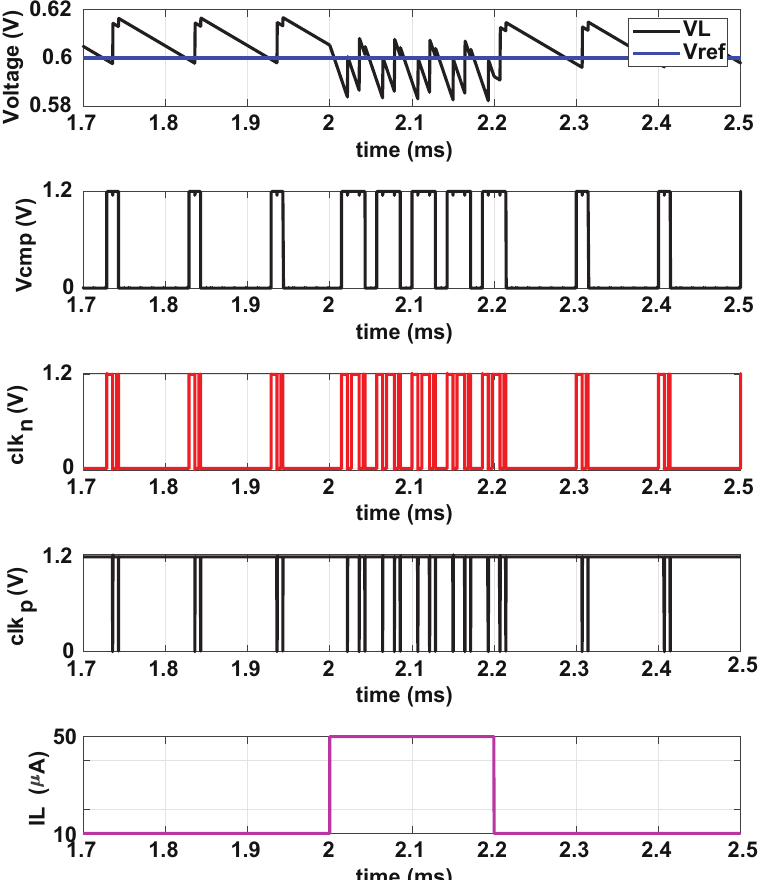
Figure 9. Transient response of the SI boost regulator at V L = 0.6 V when I L changes from 10 µ A to 50 µ A.